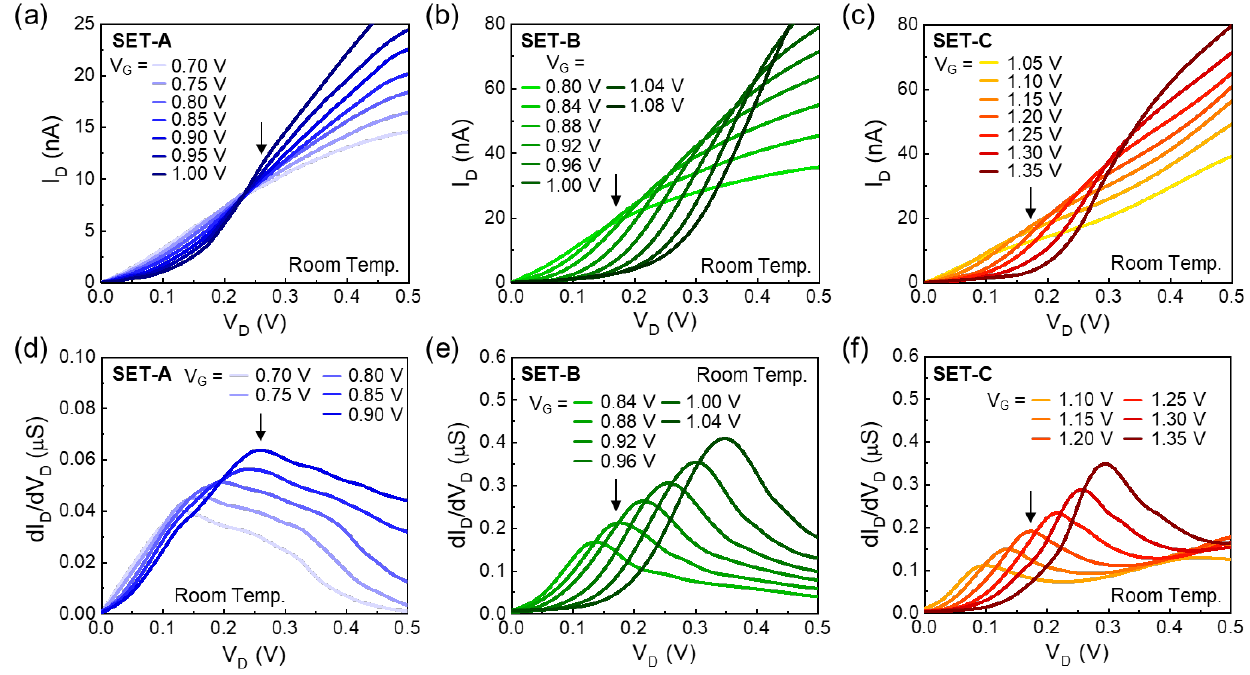
Figure 4. I D –V D output characteristic curves at various V G near the Coulomb blockade regions for ( a ) SET-A, ( b ) SET-B, and ( c ) SET-C, and dI D /dV D –V D curves of ( d ) SIA, ( e ) SET-B, and ( f )